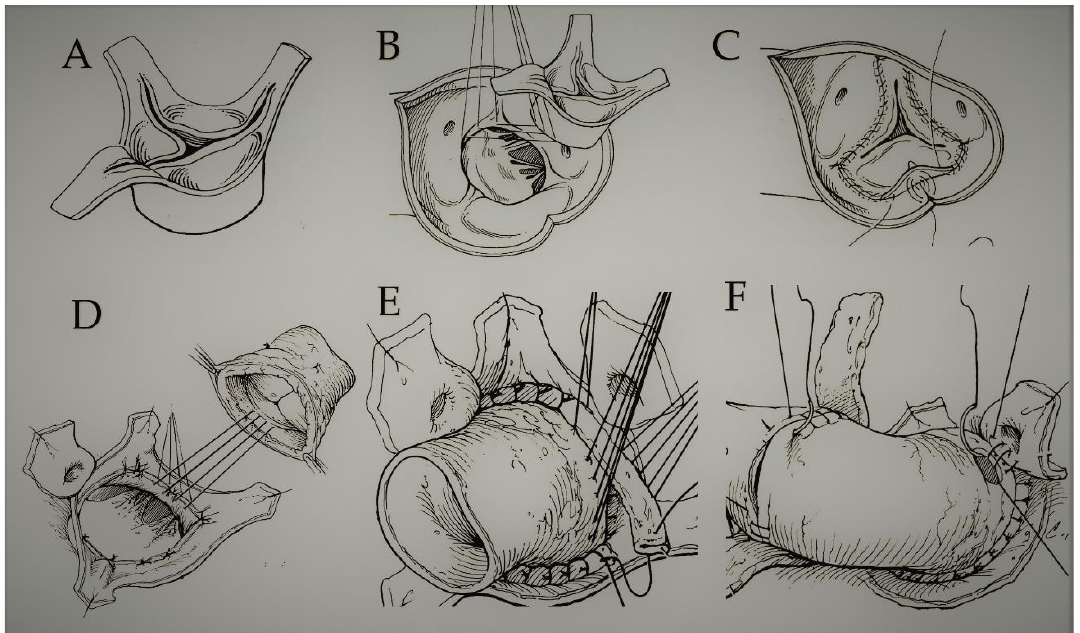
Figure 1. ( A – F ) The pulmonary autograft can be implanted using 2 methods. ( A – C ) Subcoronary implantation or ( D – F ) free-end/mini-root technique. In the subcoronary technique, the pulmonary valve is taken and inserted only with its leaflets and annulus. In the mini-root technique, the pulmonary valve is implanted with its pulmonary trunk so that the PA is withdrawn from the infundibulum of the right ventricle, respecting its morphology. Abbreviation; PA, pulmonary autograft.